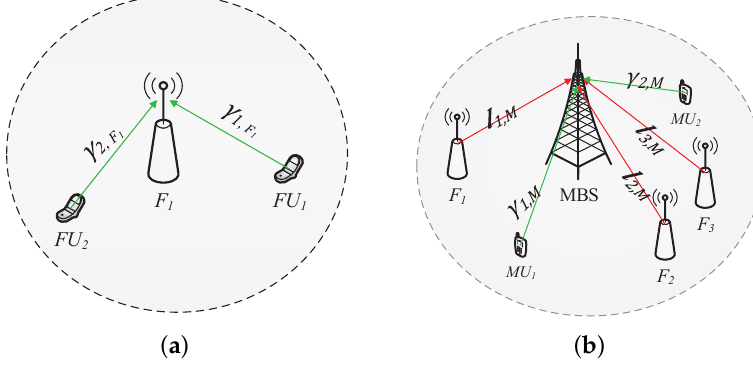
Figure 2. Auction-based pricing procedure for spectrum leasing. ( a ) femtocell base station (FBS) service price determination; ( b ) macrocell base station (MBS) service price and spectrum leasing price